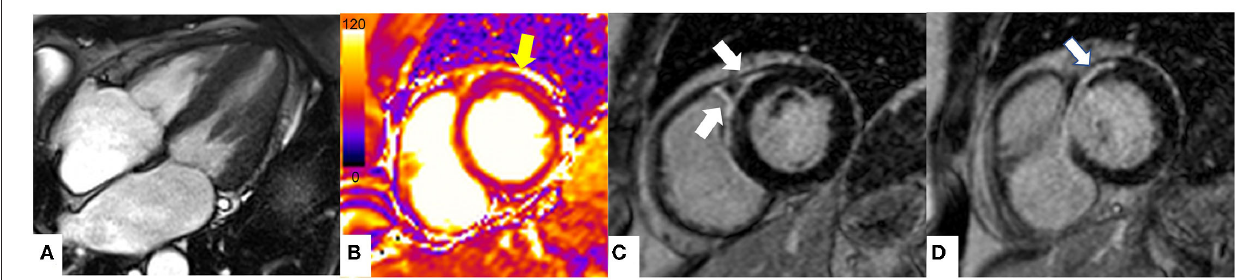
FIGURE 5 | The role of CMR in non-ischemic cardiomyopathies mimicking MINOCA. CMR findings in a patient with known cardiac sarcoidosis presenting with chest pain. (A) Steady state free precession sequence (SSFP) cine sequence 4 chamber (end-systole) showing preserved ventricular systolic function (B) T2 mapping (basal segments) showing high T2 values (arrow) in the basal anterior wall (T2 = 62ms, normal values T2 < 55ms at 1.5T) suggestive of myocardial oedema. (C, D) Late gadolinium enhancement imaging (LGE) at the level of basal segments demonstrating prominent subepicardial to mid wall enhancement in the basal anteroseptum and anterior wall extending into the adjacent right ventricular anterior wall (arrows). The pattern of myocardial injury noted is in keeping with acute cardiac involvement in